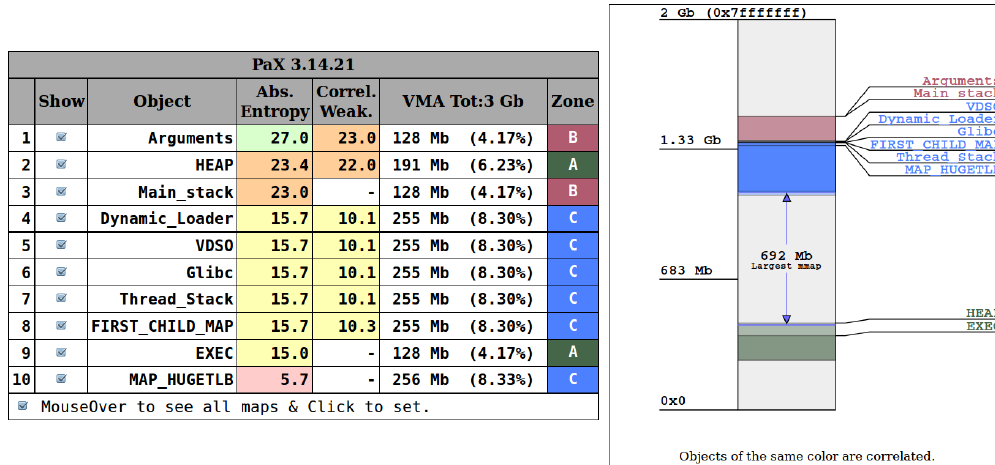
Figure 11. ASLR analyzer: Screenshot of PaX Heap (brk) on i386.